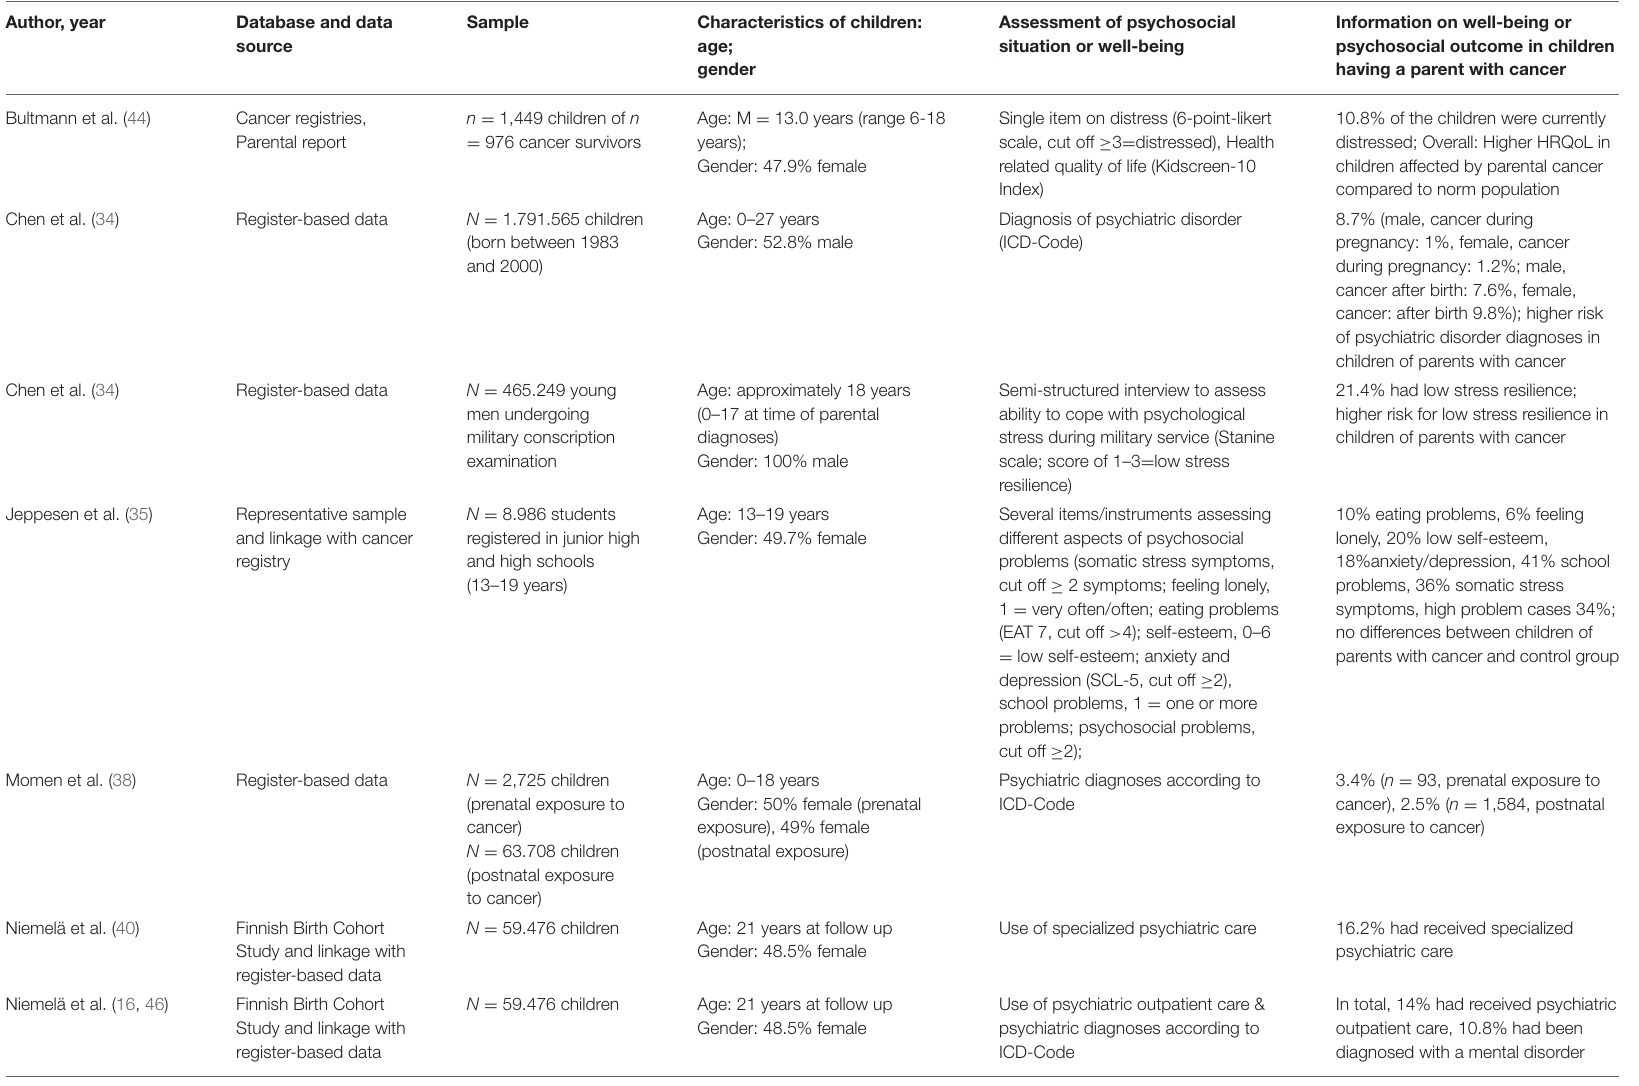
TABLE 3 | Study characteristics and estimates of psychosocial situation or well-being of children and/or young adults having a parent with cancer from n = 7